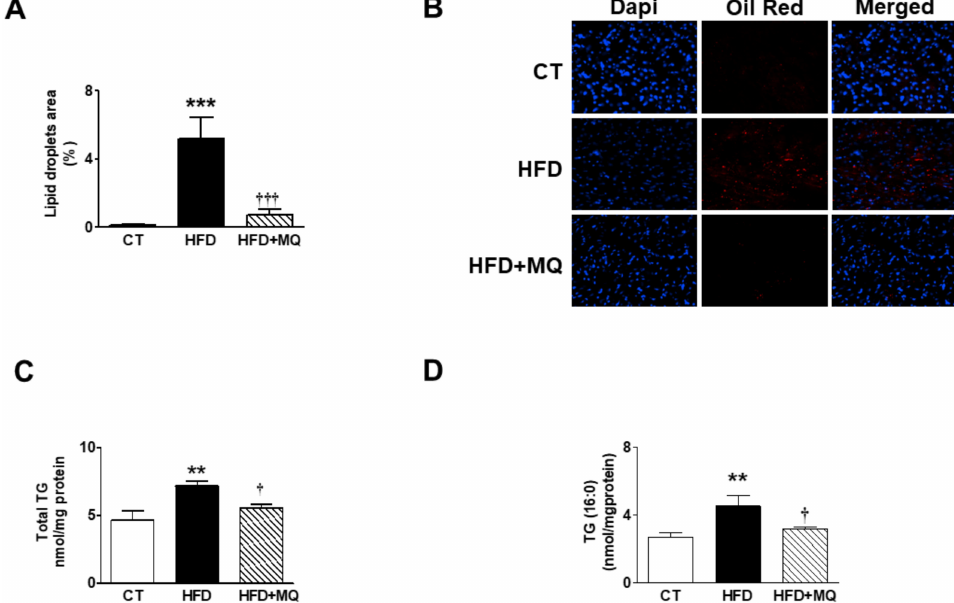
Figure 2. Impact of the mitochondrial antioxidant MitoQ (MQ) on lipid droplet content and mitochondrial triglycerides in the hearts of obese rats. Hearts from rats fed a standard diet (CT) or a high fat diet (HFD) treated with vehicle or with MQ (200 µ M) were analyzed. ( A ) Quantification of intracellular lipid accumulation and ( B ) representative microphotographs of sections stained with DAPI and Oil red O to visualize and quantify nuclei and intracellular lipid droplets, respectively. ( C ) Levels of total mitochondrial triglycerides (TGs) and ( D ) mitochondrial TGs enriched with palmitic acid (PA; C16:0) are presented. Magnification ( × 40). Bar graphs represent the mean ± SEM. of 6–8 animals. ** p < 0.01; *** p < 0.001 vs. control group. † p < 0.05; ††† p < 0.001 vs. HFD